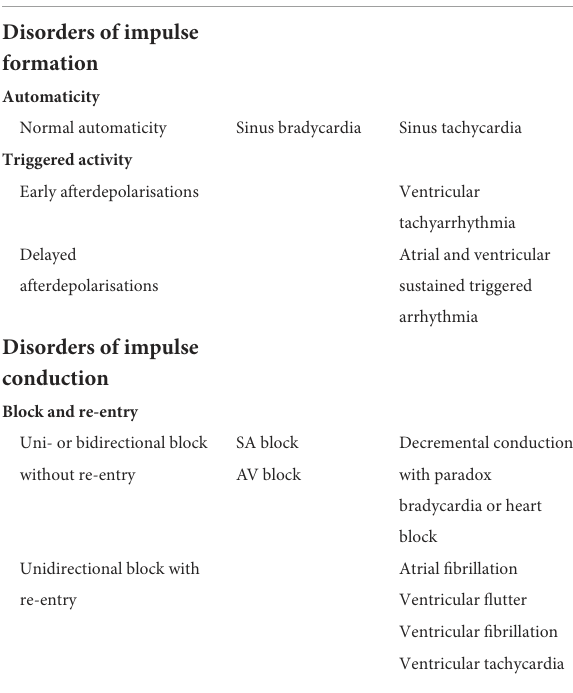
TABLE 1 Mechanisms of arrhythmia in different thyroid conditions (76,